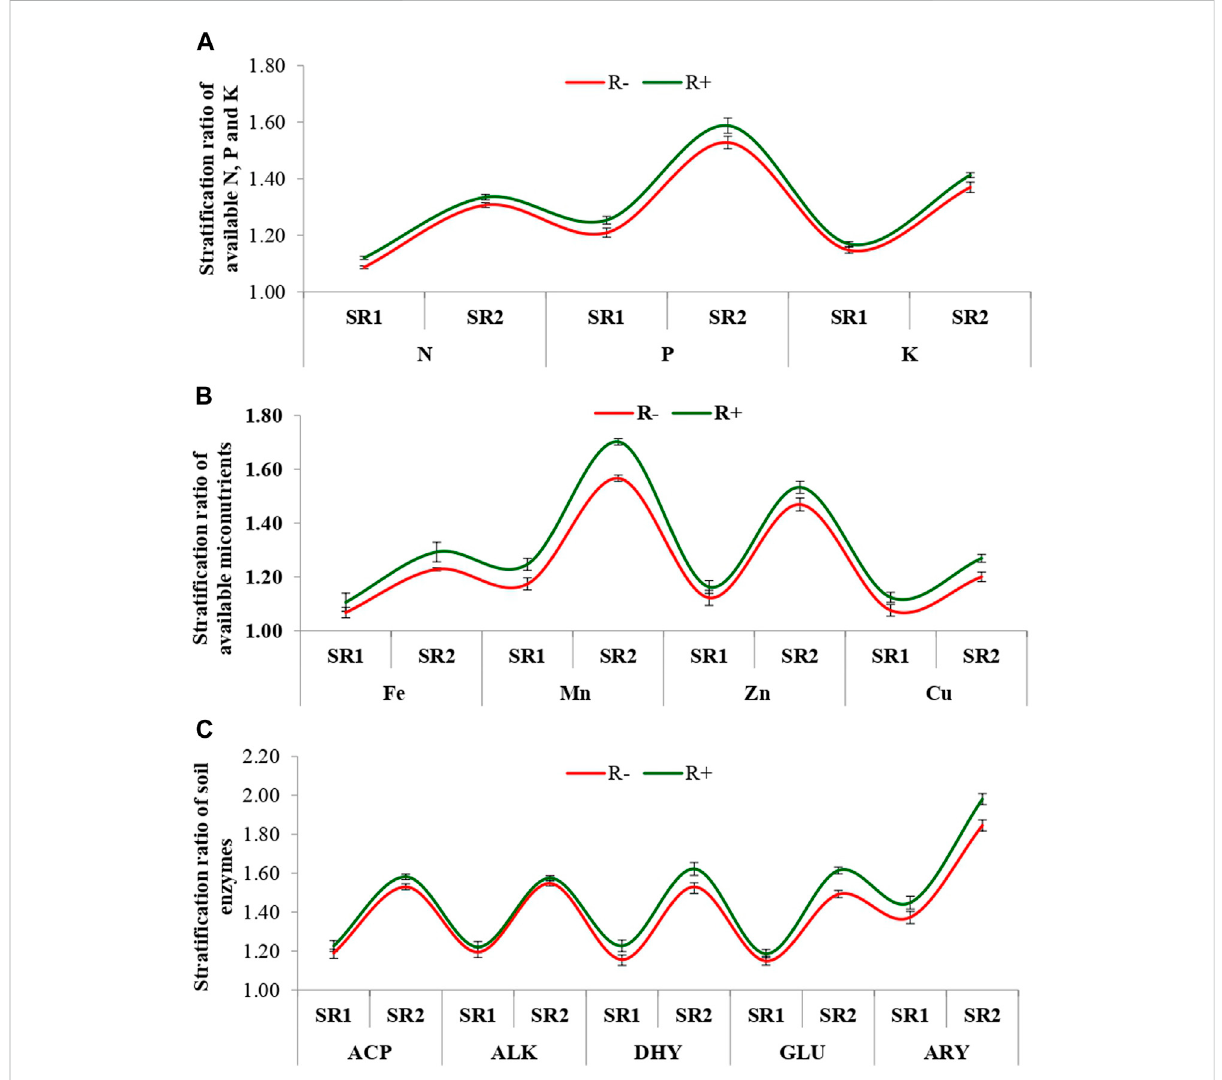
FIGURE 3 Strati fi cation ratios of (A) . Available N, P, and K (B) . Micronutrients Fe, Mn, Zn, and Cu (C) . Soil enzymes as in fl uenced by residue management after fi ve years of experimentation. NGM: No green manuring, GGM: greengram green manuring, CGM: cowpea green manuring, SGM: sesbania green manuring, R-: residue removal, R+: residue retention SRI: strati fi cation ratio (ratio of 0 – 0.15 and 0.15 – 0.30 m soil depth), SR2: strati fi cation ratio(ratioof0 – 0.15and0.15 – 0.30 msoildepth).ACP:Acidphosphates(umolpNPg -1 ),GLU:betaglucosidase(ugg -1 ofh- 1 ),ARY:arylsulfatase activity (ug pNP g -1 of soil h -1 ). Vertical bar (both way ) represents the standard error of mean (p <